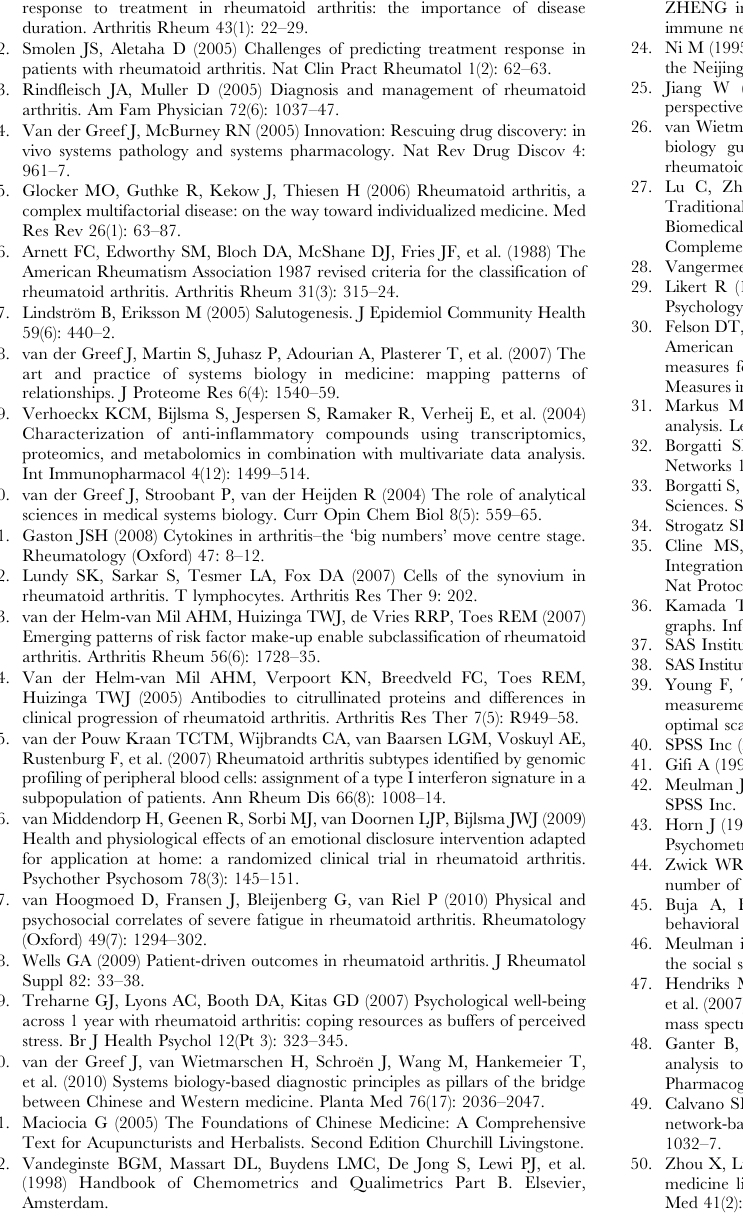
Table S2 VAF table for the analysis presented in Figure